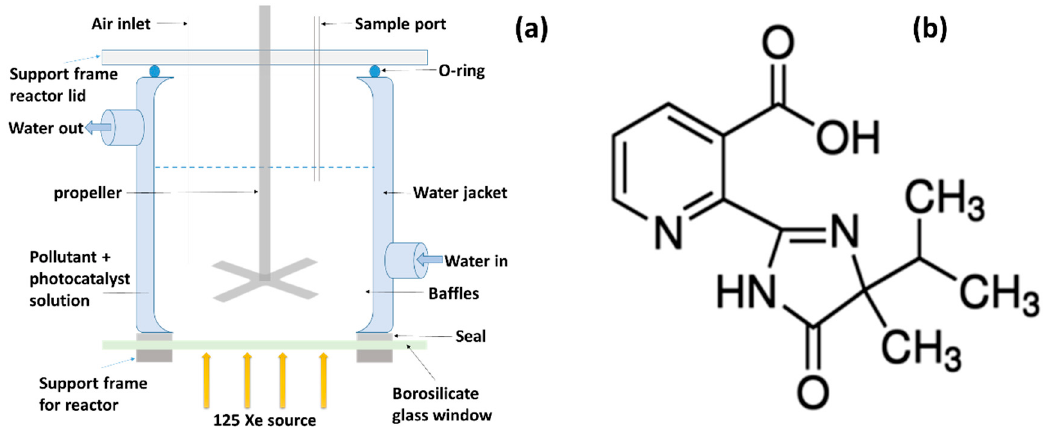
Figure 1. ( a ) Schematic representation of a stirred rank reactor and ( b ) chemical structure of imazapyr imazapyr herbicide.